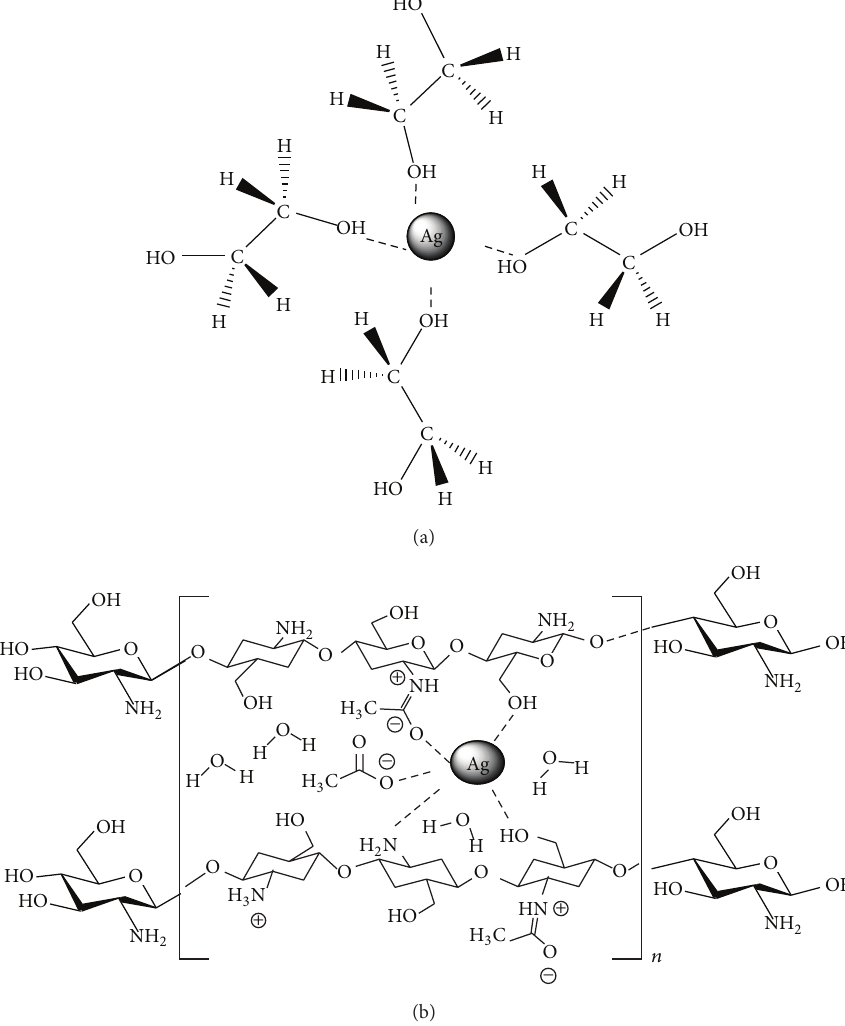
Figure 6: Mechanism of capping Ag-NPs by (a) ethylene glycol and (b) chitosan.